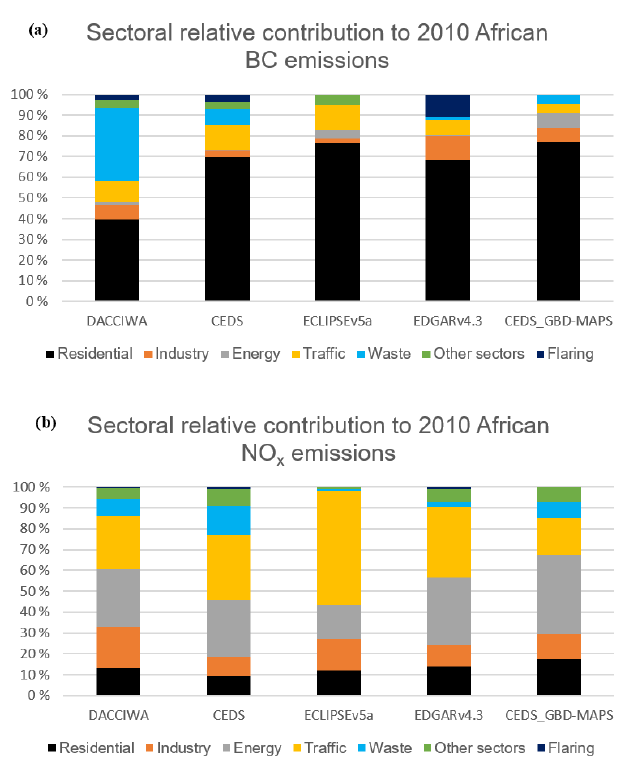
Figure 7. Sectoral relative contribution for BC (a) and NO x (b) emissions in 2010 for CEDS, CEDS_GBD-Maps, ECLIPSEv5a, EDGARv4.3 and DACCIWA (this work)